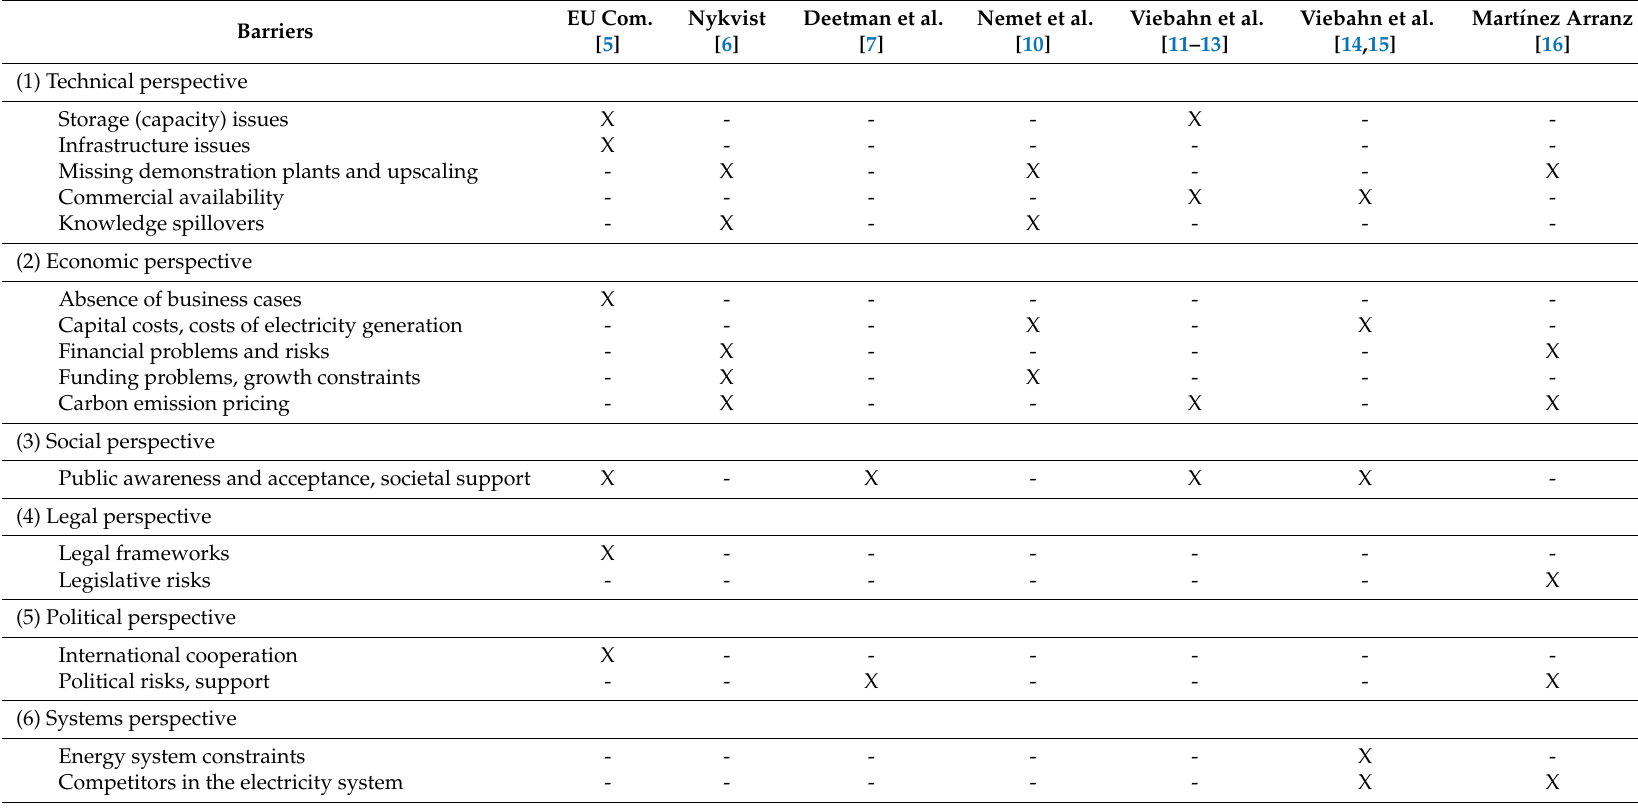
Table 1. Barriers for the implementation of carbon capture and storage (CCS) from different